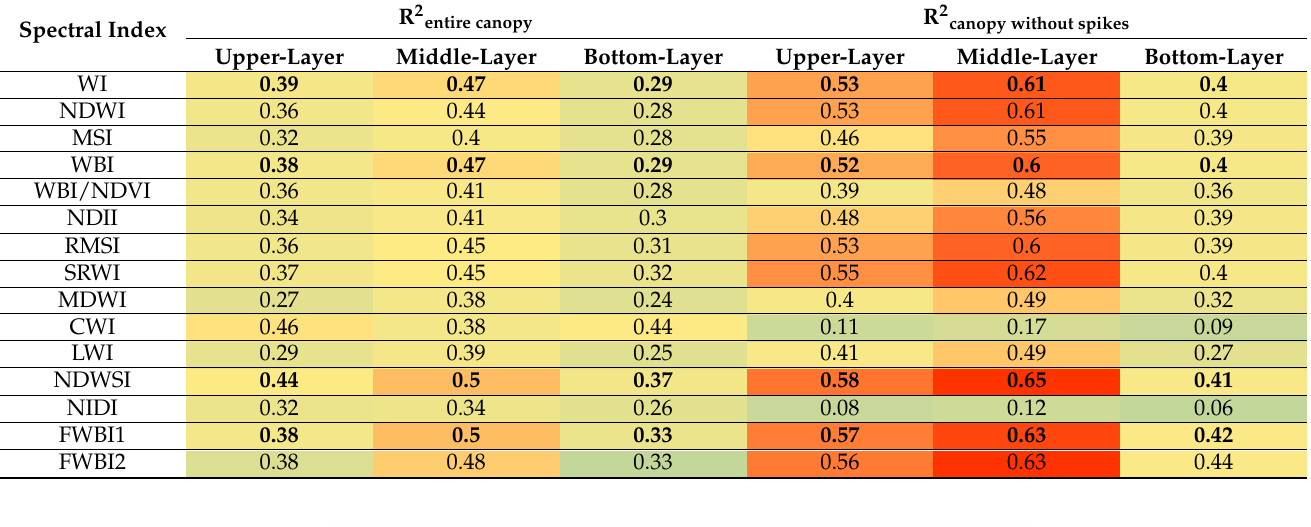
Table 3. The R 2 entire canopy and R 2 canopy without spikes between published spectral indices and the LWC in different vertical layers. Colors correspond to the level of performances of spectral indices, from light blue for minimum R 2 value to red for maximum R 2 value.